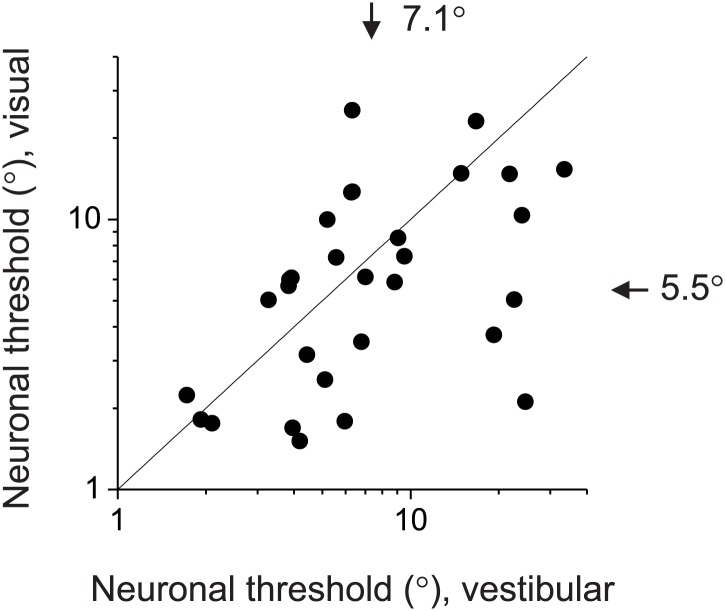
Comparison of neuronal sensitivity between the visual (ordinate) and vestibular (abscissa) stimulus conditions for 30 congruent cells.Arrows and numbers indicate geometric mean values. Overall, visual responses were somewhat more sensitive than vestibular responses, although the animals’ behavioral performance was similar between conditions.